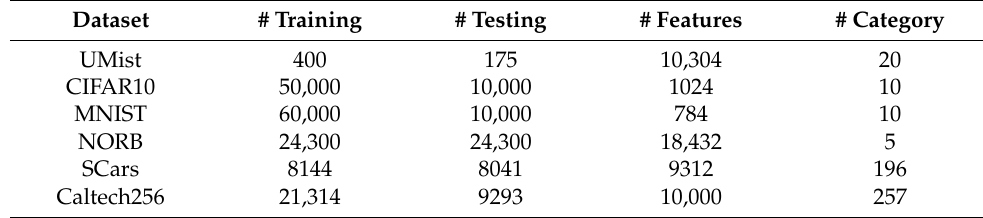
Table 1. Information from the databases to train the ELM-AE. Dataset